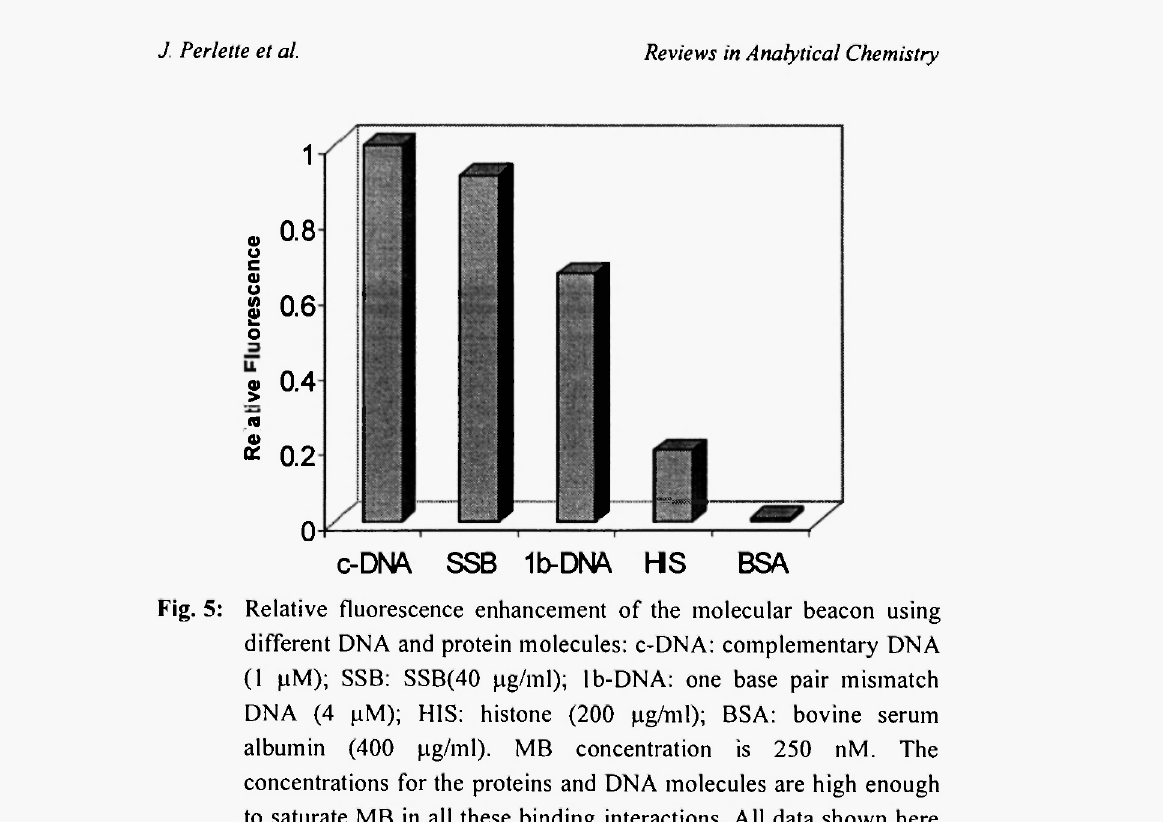
Fig. 5: Relative fluorescence enhancement of the molecular beacon using different DNA and protein molecules: c-DNA: complementary DNA (1 μΜ); SSB: SSB(40 μ§/ιη1); lb-DNA: one base pair mismatch DNA (4 μΜ); HIS: histone (200 μβ/ηιΐ); BSA: bovine serum albumin (400 μ§/ιη1). MB concentration is 250 nM.